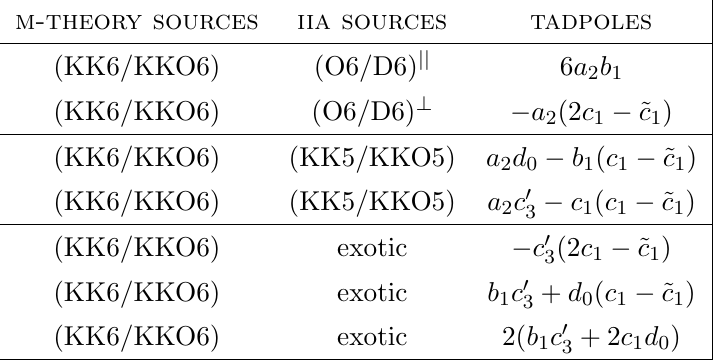
Table 2 . The (cid:13)ux tadpoles supporting the M-theory (cid:13)ux backgrounds in table 1 and their weakly coupled type IIA interpretation. Eleven dimensional KK monopoles turn out to produce either D6 branes or type IIA KK monopoles, when reduced on the isometry direction or a worldvolume direction, respectively. However, they may give rise to exotic objects with no clear IIA description when reduced along a transverse